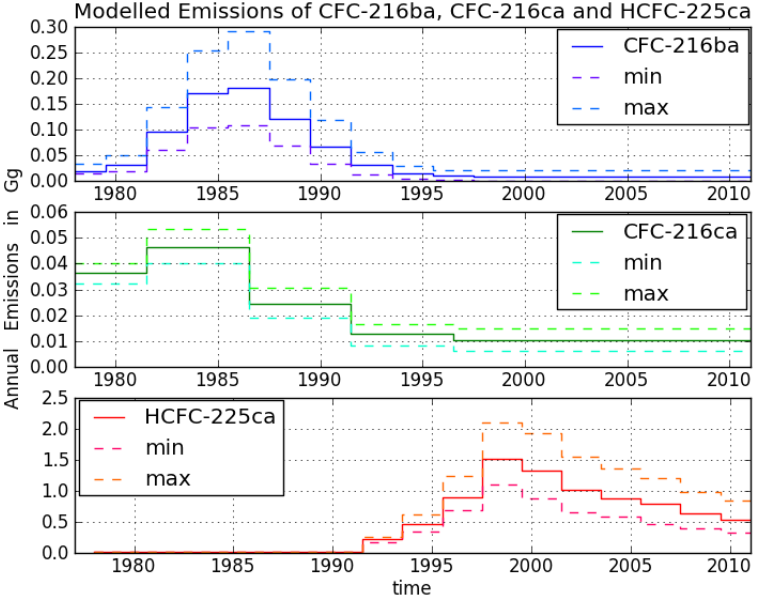
Figure 4. Global annual emission estimates of CFC-216ba, CFC-216ca and HCFC-225ca based on 2D atmospheric modelling. Uncertainty ranges for the CFCs were calculated based on uncertainties in the atmospheric lifetime estimates, calibration, measurement and modelling uncertainties. Uncertainty ranges for HCFC-225ca were calculated based on uncertainties in OH reaction rates [28] and measurement